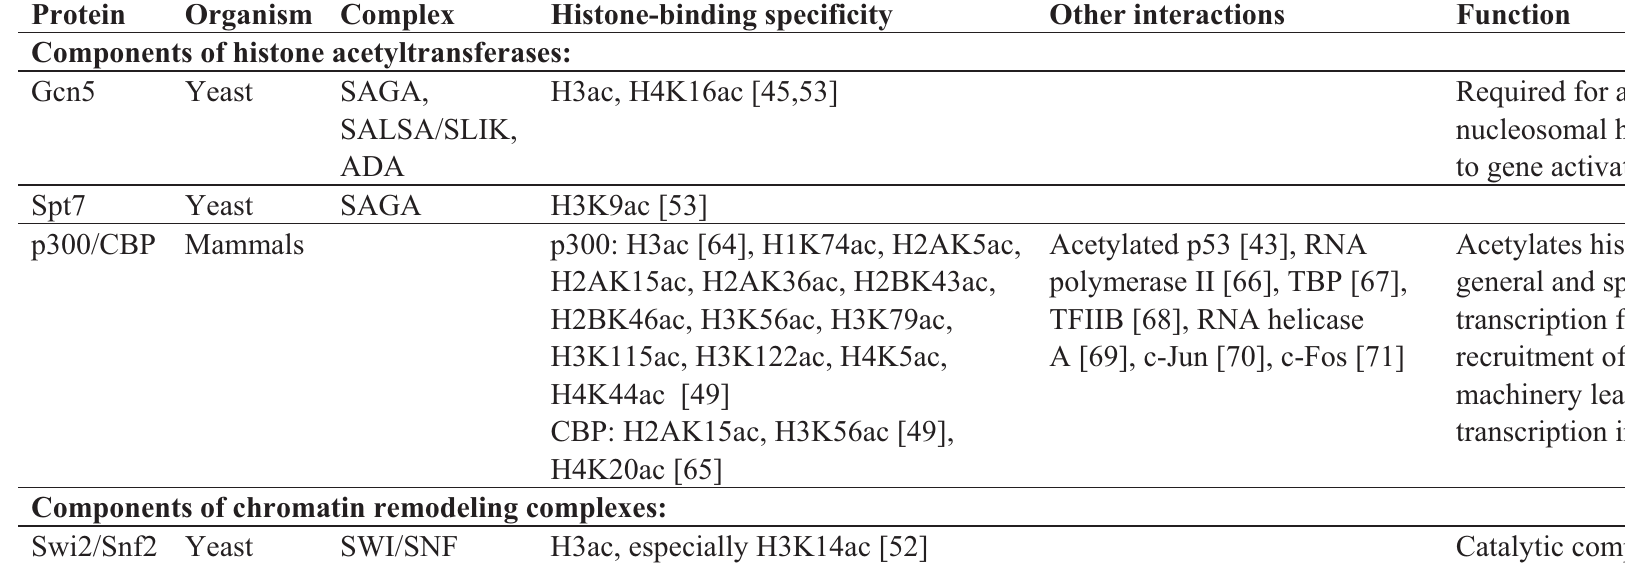
Table 1. Selected bromodomain proteins in budding yeast and